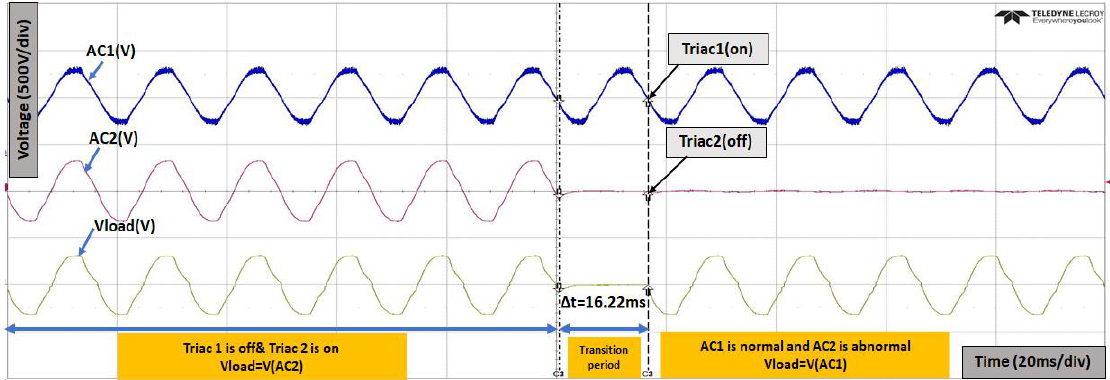
Figure 15. Experimental voltage waveforms and transition time calculations when the AC2 source is faulted at the point of zero-crossing.